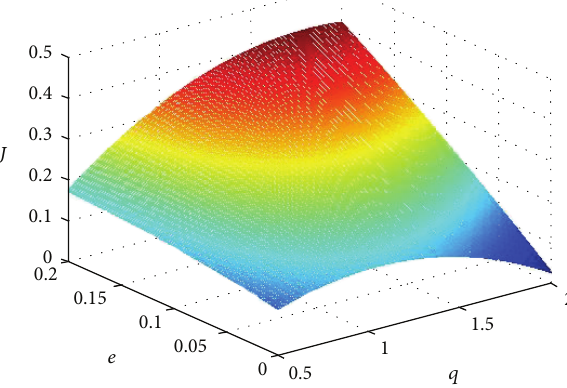
Figure 5: Diagram of social welfare in corporate effort and